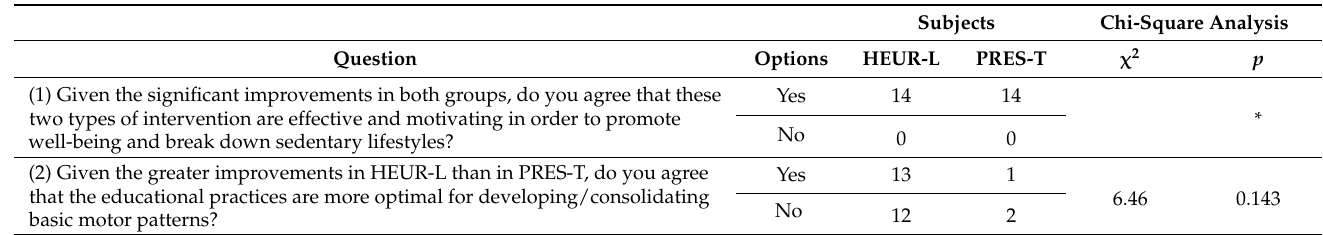
Table 4. Differences in awareness of the activity performed between HEUR-L and